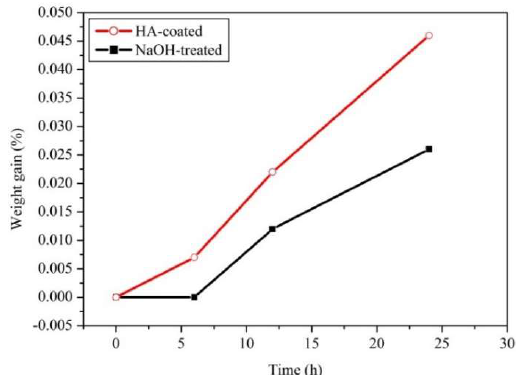
Figure 8. Weight gain as a function of soaking time for the surfaces of NaOH-treated c.p. Ti and HA-coated c.p. Ti that were subjected to heat treatment at 500 ◦ C for 2 h after subsequent soaking for di ff erent periods in